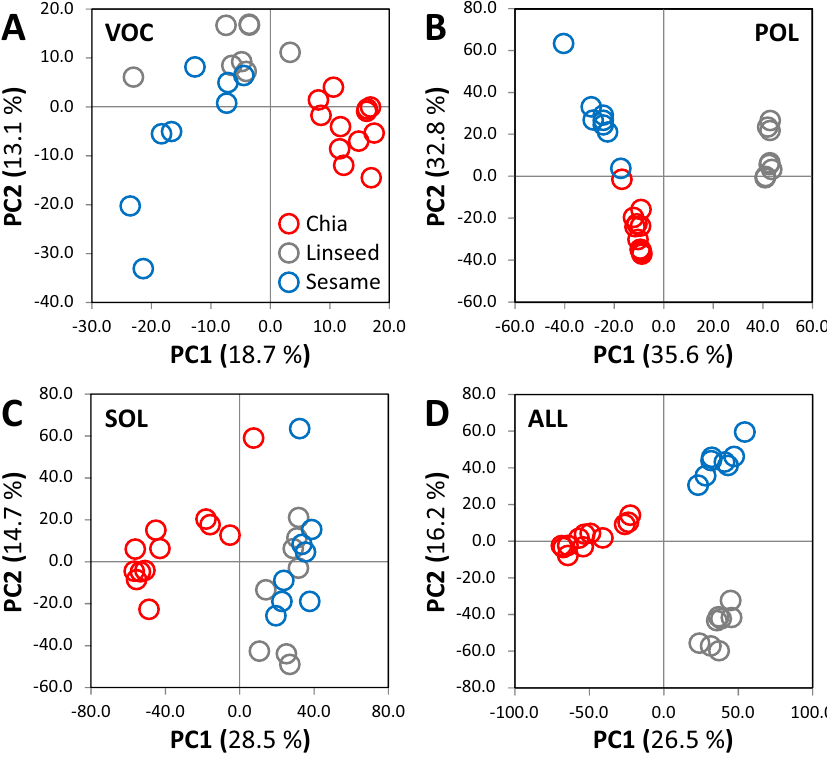
Figure 2. Principal component analyses (PCA) of non-targeted metabolite profiles of three chemical fractions from chia (n = 12), linseed (n = 8) and sesame seeds (n = 8). Matrices of averaged mass features across technical replicates (t) from the VOC (t = 6), POL (t = 5) and SOL (t = 2–5) profiles of the 28 seed batches (S_01 - S_28) were submitted to PCA analysis (Table S2). The first two components of each separate PCA, VOC ( A ), POL ( B ), SOL ( C ), and a PCA of the combined data sets ( D ) are plotted. Log 10 -transformed mean-centred ratios of each mass feature were calculated prior to PCA. Missing value (NA) replacement was an estimate of the detection limit (Fig. 4) before calculation of log 10 -transformed